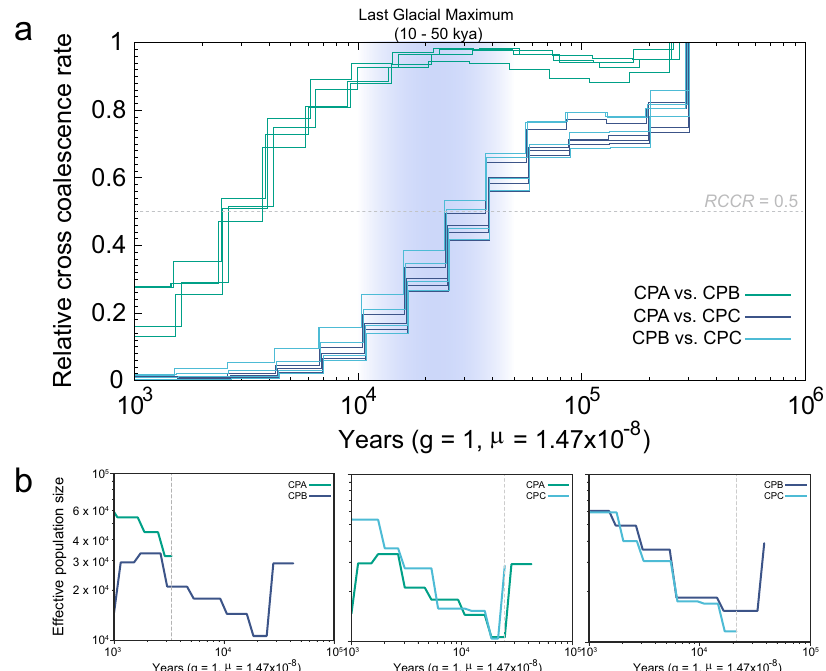
Fig. 3 Population separation inferences in each pair of Chinese pangolin populations. a The split time of CPA vs. CPB, CPA vs. CPC, and CPB vs. CPC populations was calculated by the MSMC2 software. Each line indicated a pair of separation inferences by randomly selecting two individuals. The grey dashed line represented that relative cross coalescence rate (RCCR) of 0.5. The Last Glacial Maximum period is indicated by purple vertical bars. b The split time between CPA vs. CPB, CPA vs. CPC, and CPB vs. CPC populations inferred by the SMC ++ software. The lines represent the CPA (green), CPB (purple) and CPC (blue) populations. The grey dashed line denotes the divergence between two populations.